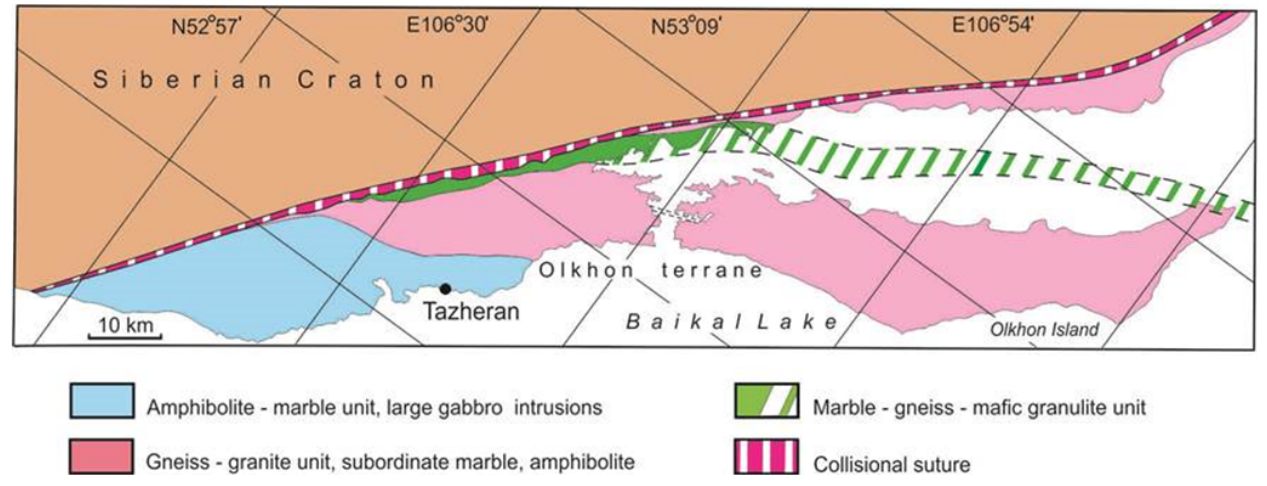
Figure 2. Simplified tectonics of the Olkhon terrane, modified after [15]. Tazheran Massif is shown as a black circle.